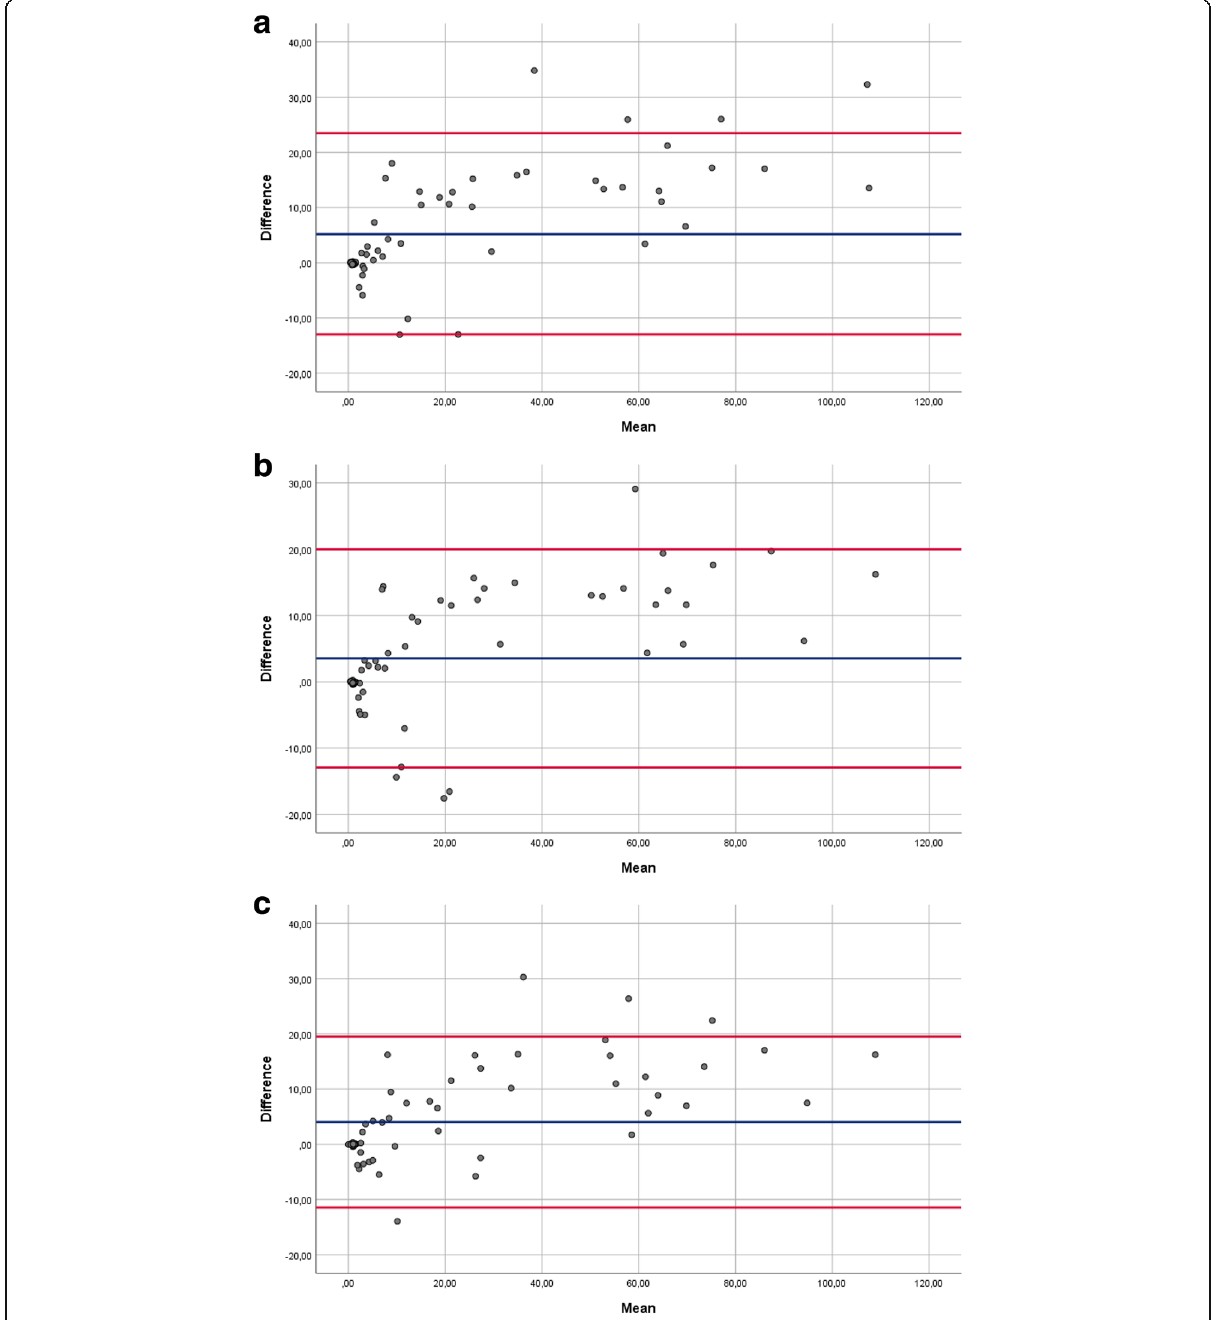
Fig. 5 Bland-Altman-Plots showed a low correlation for the continuous measurement values between the radiographs of a positioning I, b positioning II, c positioning III and the corresponding CT scans (upper red line: + 1.96xSD, blue line: mean of the difference, lower red line: −